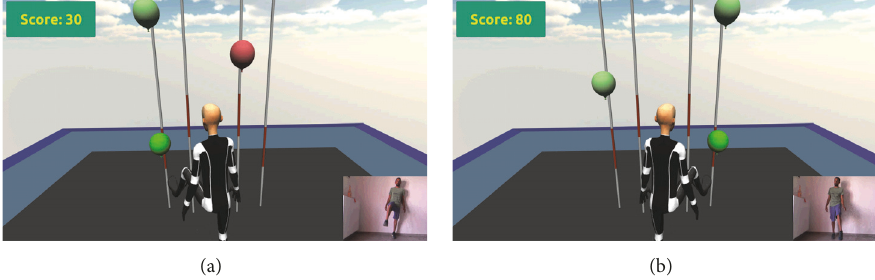
Figure 5: Balloon Goon Game. Sample screenshots of a left (a) and a right (b) “kick” animation performed by the avatar shown in the main screen. Each of these animations is triggered by successfully detecting a left/right “Leg Extension” gesture executed by the human actor, as shown in the corresponding bottom right corner insert for each